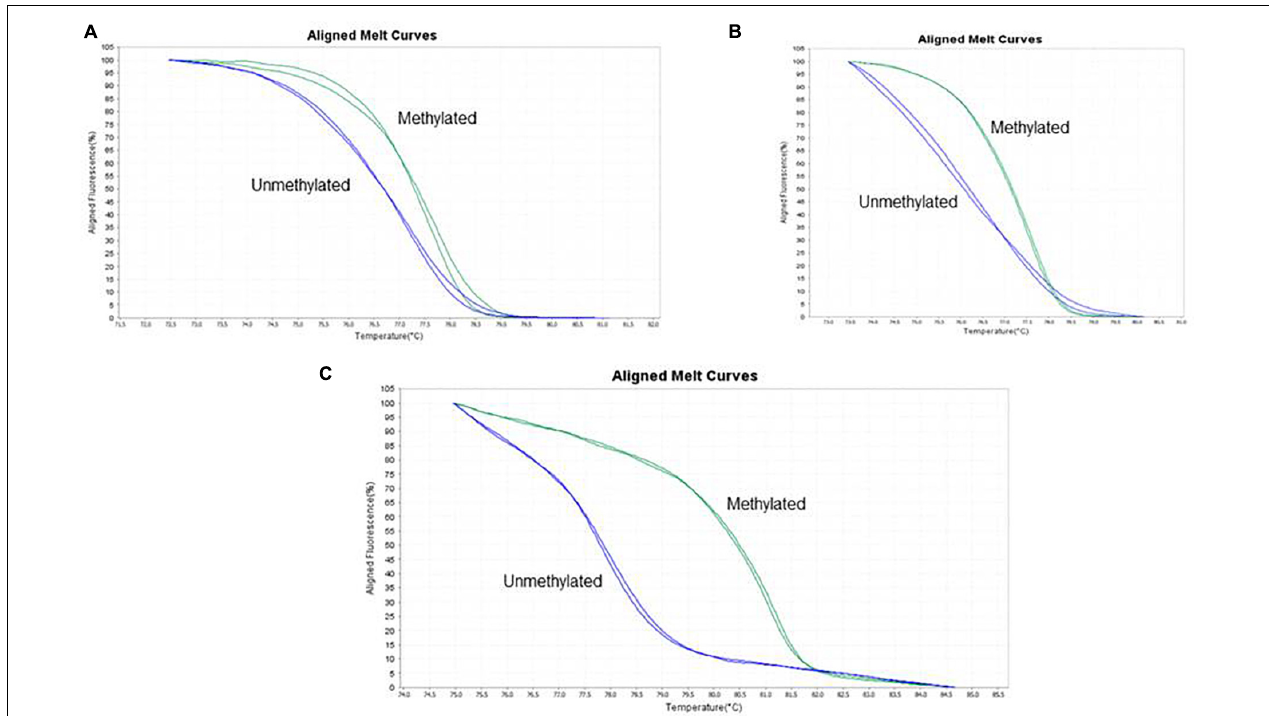
FIGURE 1 | The screen printed shows the interpretation of the raw data generated by the StepOne equipment after the HRM assay is processed, having been generated by the High Resolution Melting software. The melting of a DNA fragment consists in successive dissociations and the melting temperature differs depending on the GC content in each sequence. Melting curves are aligned according to the fluorescence level established for each methylation parameter analyzed. The figure shows alignment of methylation control curves with patient samples. (A) BDNF exon 1 promoter region, (B) BDNF exon IV promoter region, and (C) SLC6A4 promoter region. Each image shows one sample comparing to one control showing the similarity of the aligned curves; the unmethylated curve ranged from 0 to 25% and for the methylated curve from 75 to